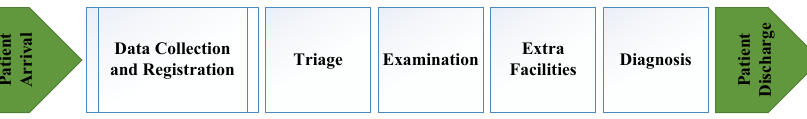
Figure 10. Patient journey in the